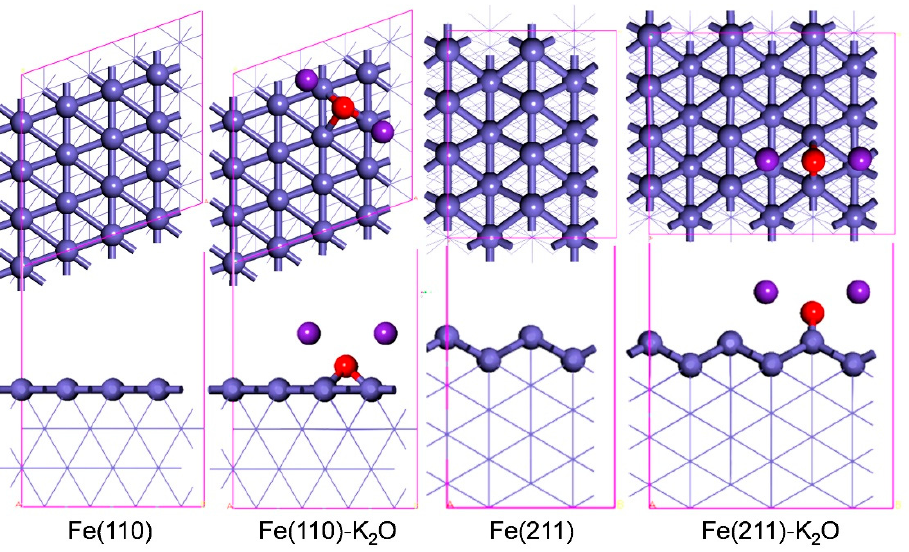
Figure 5. The top and side view of the surface models for the Fe(110),Fe(110)-K 2 O,Fe(211) and Fe(211)-K 2 O. The Fe, K and O atoms are given in grayish blue, purple and red, respectively.